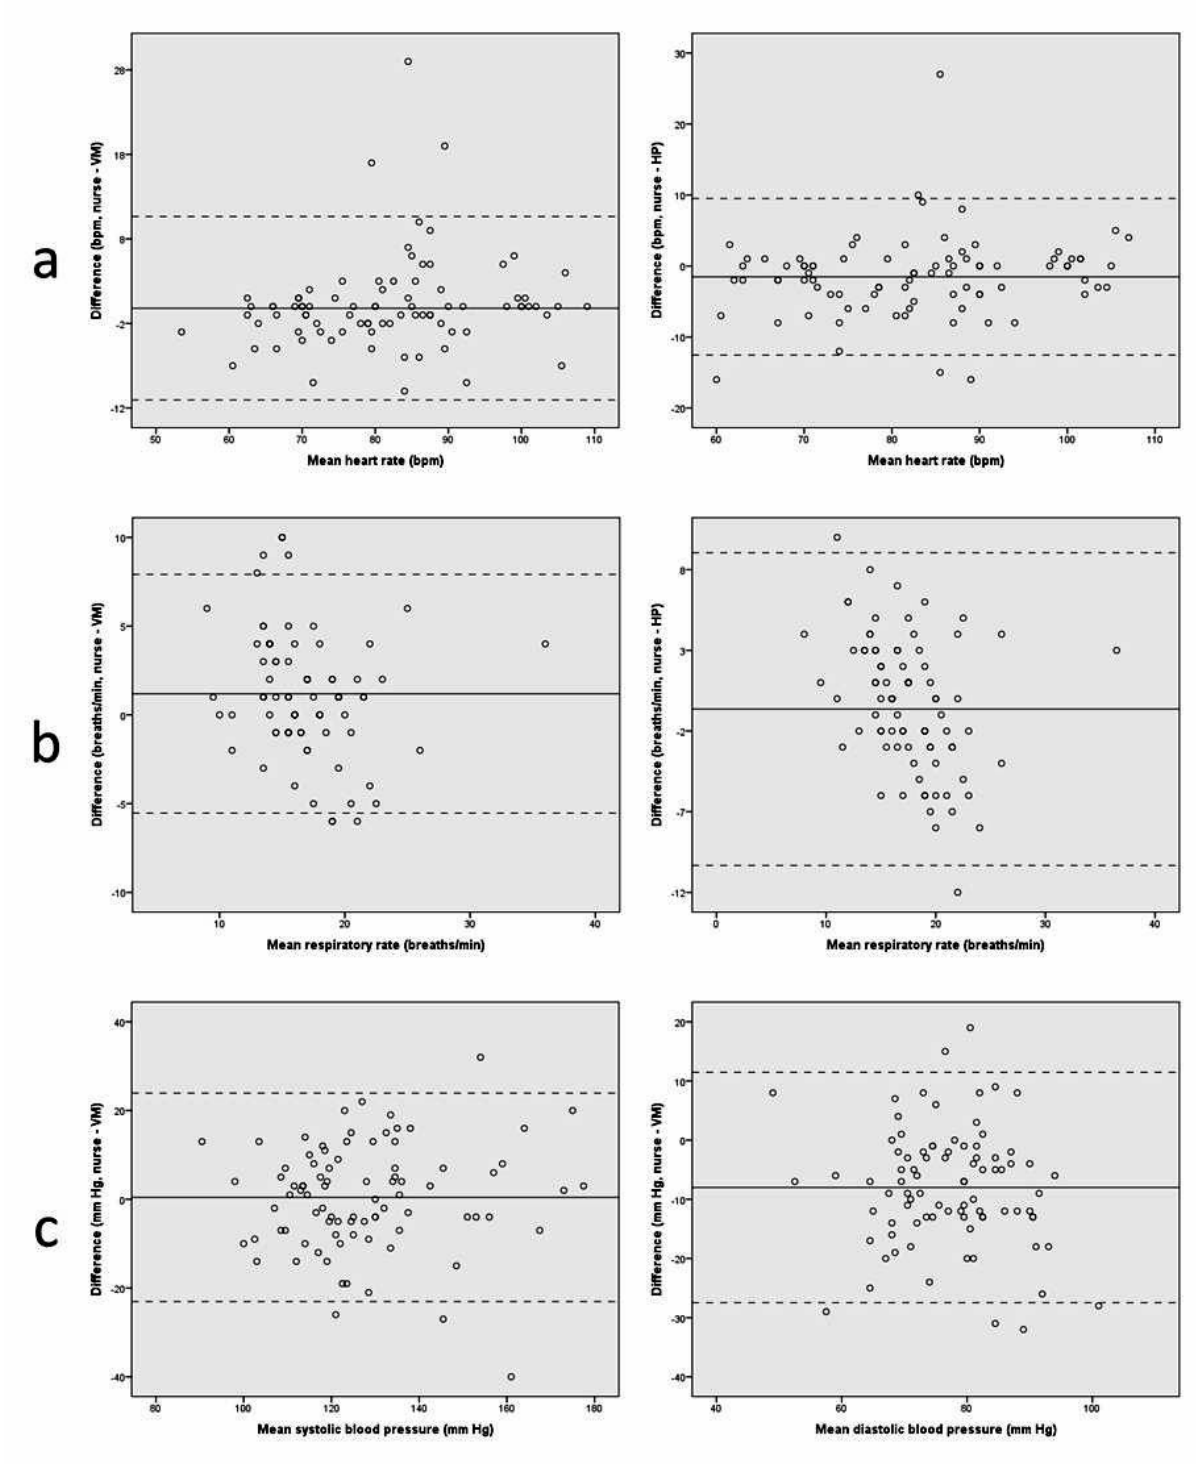
Figure 3. Bland-Altman plots: (a) heart rate (VM and HP), (b) respiratory rate (VM and HP), (c) systolic and diastolic blood pressure (VM). Dotted lines indicate mean difference and solid lines indicate limits of